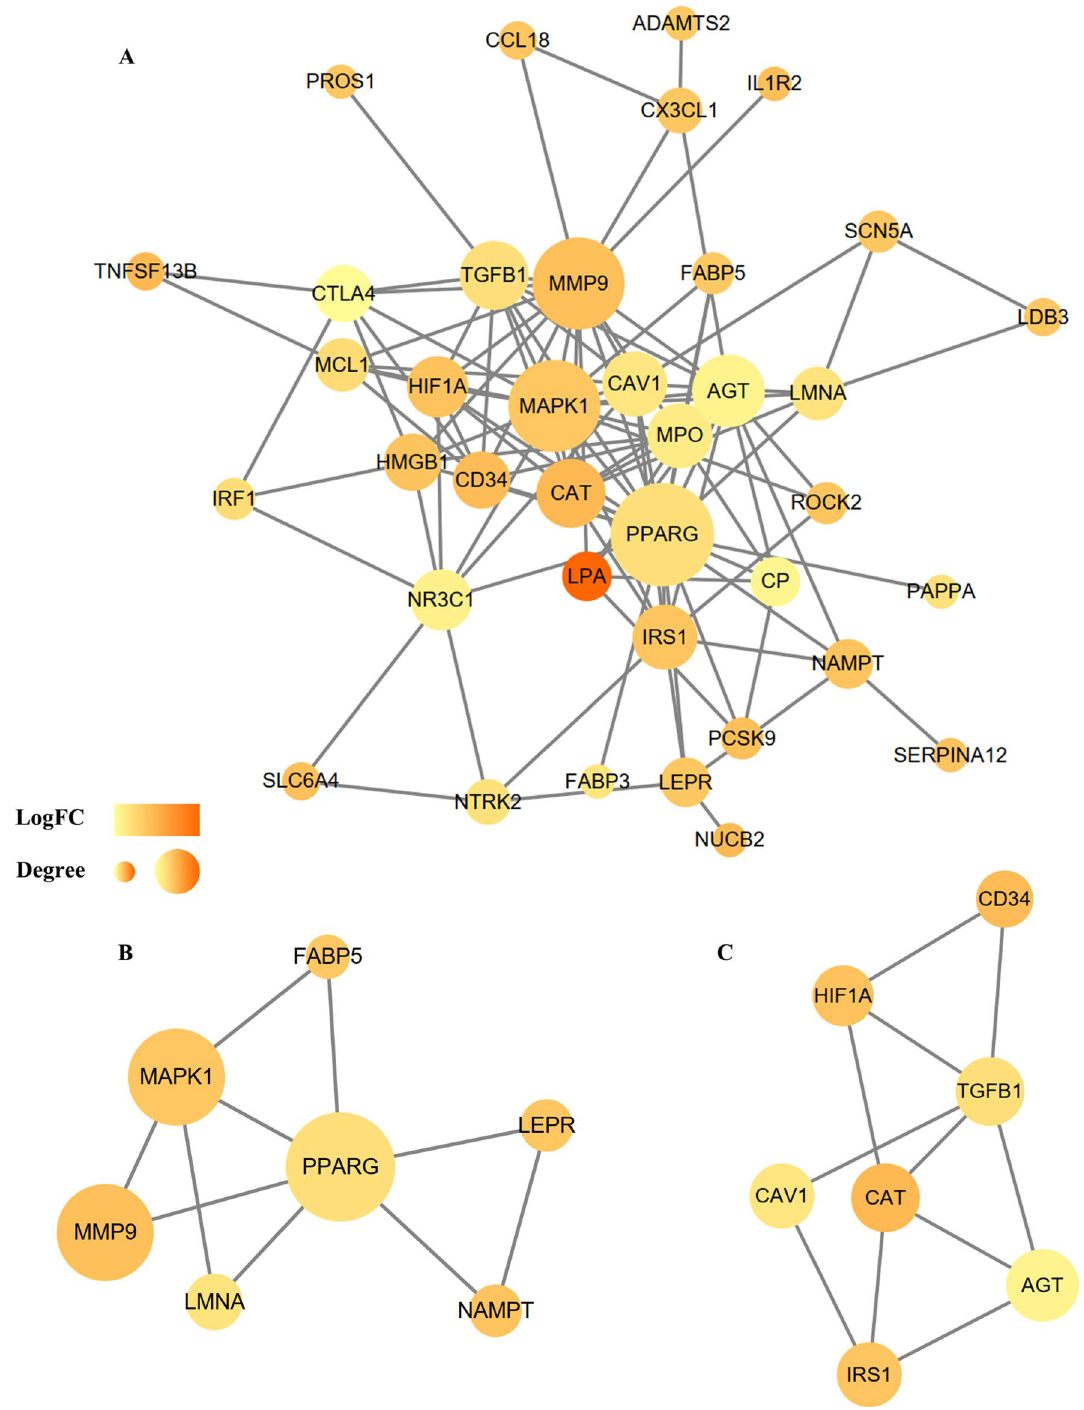
Figure 6. (A) Based on the STRING online database, 56 genes/node were filtered into the DEG PPI network. ( B) The most significant module 1 from the PPI network. ( C) The second significant module 2 from the PPI network. The color of a node in the PPI network reflects the log2 (FC) value of the Z score of gene expression, and the size of node indicates the number of interacting proteins with the designated